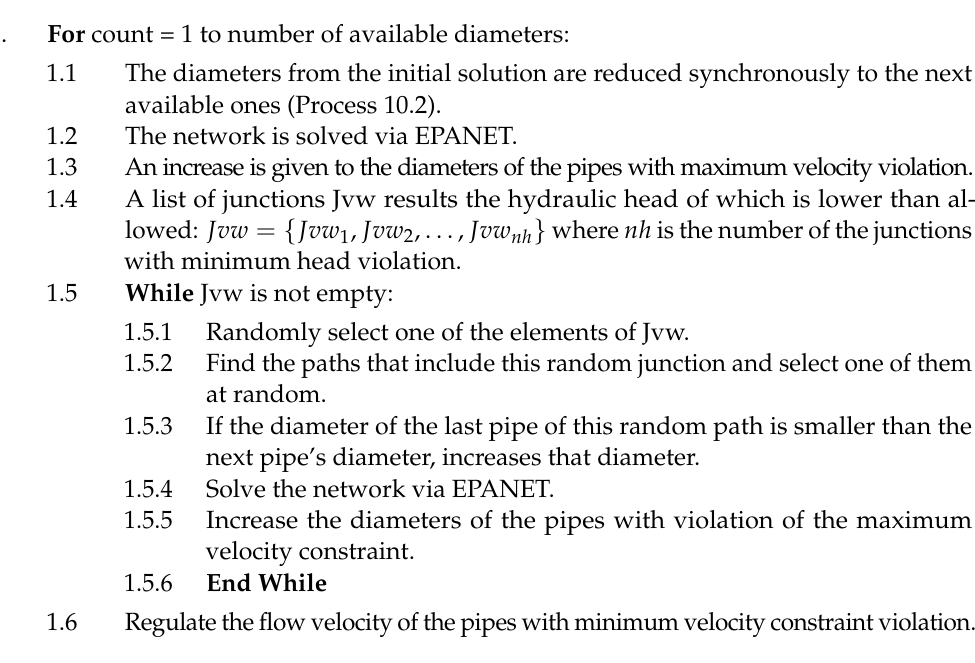
Figure 6. Flowchart of the universal reduction subroutine.